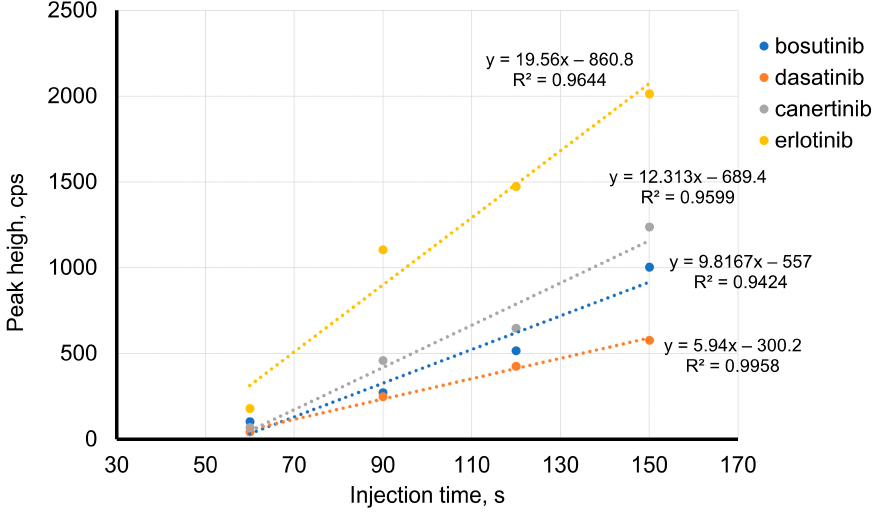
Figure 3. Effect of injection time on TKIs’ peak height BGE: 50 mM formic acid, pH 2.5; 120 cm-long capillary; injection pressure 50 mbar; voltage of 20 kV; concentration of TKIs: 10 − 7 mol.L − 1 .